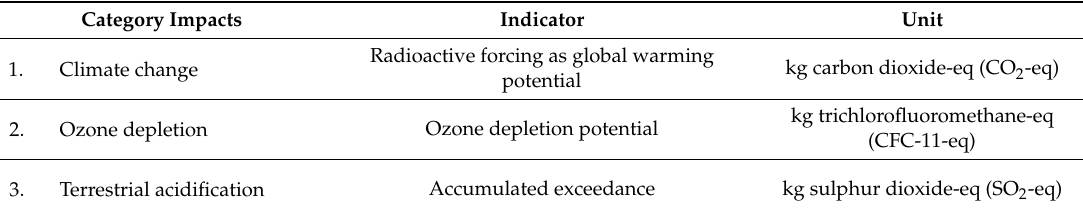
Table 2. Middle-point impact categories.